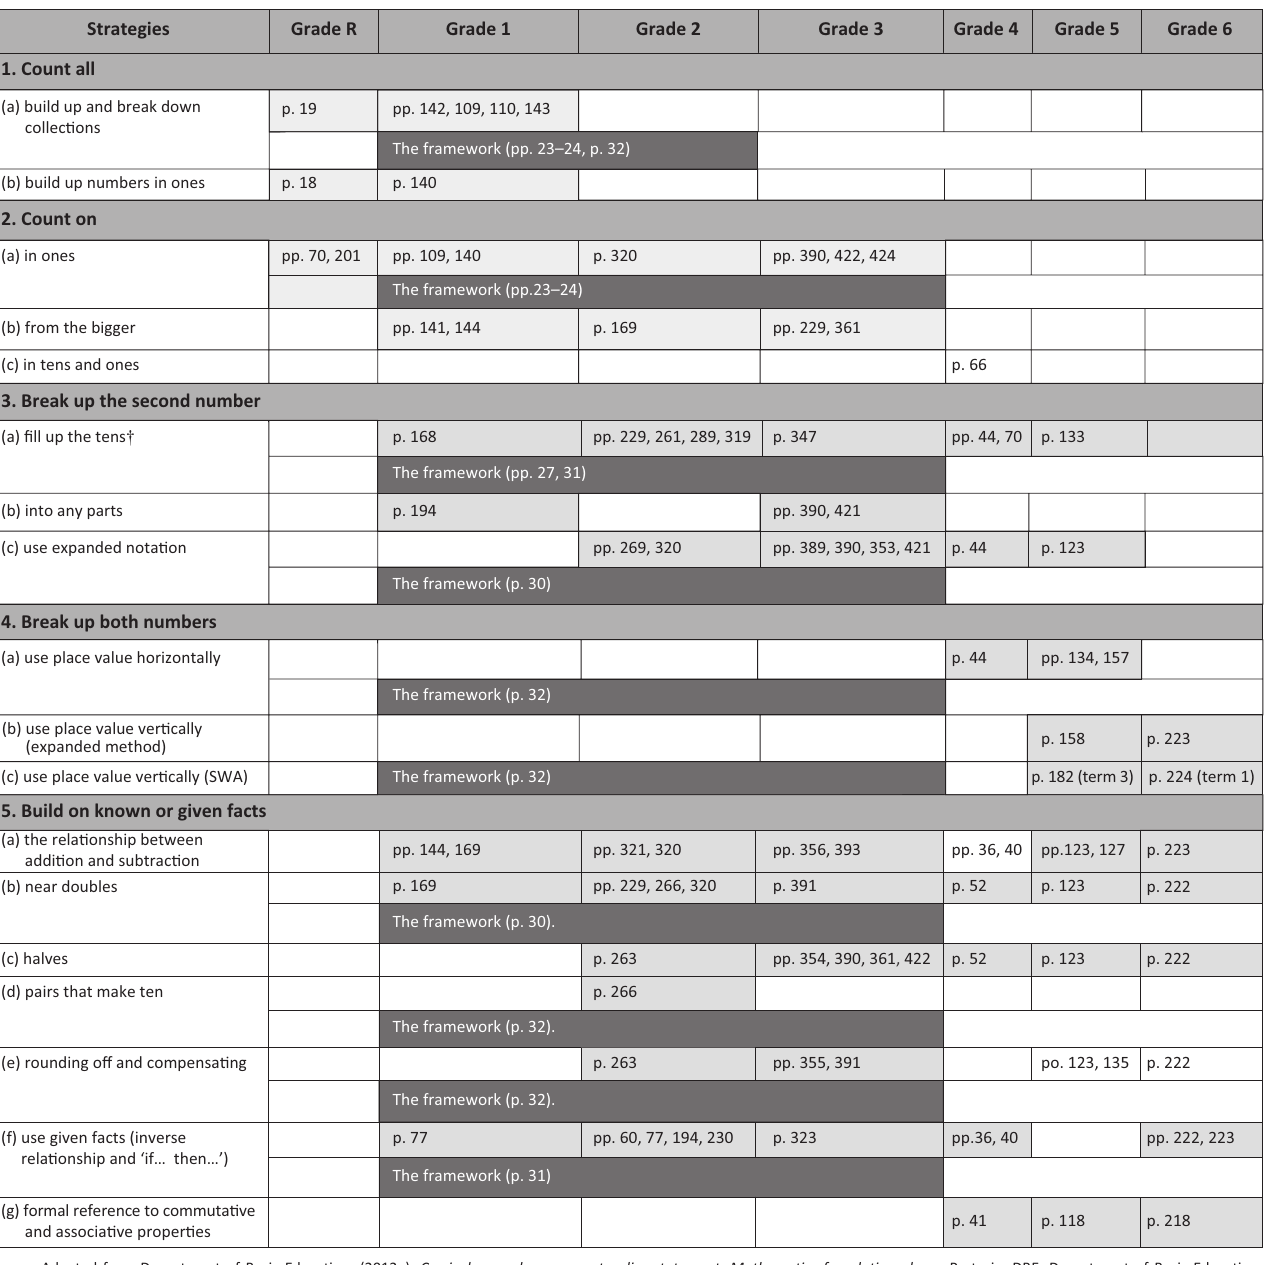
FIGURE 9: Addition strategies presented in CAPS clarification notes and the TMU